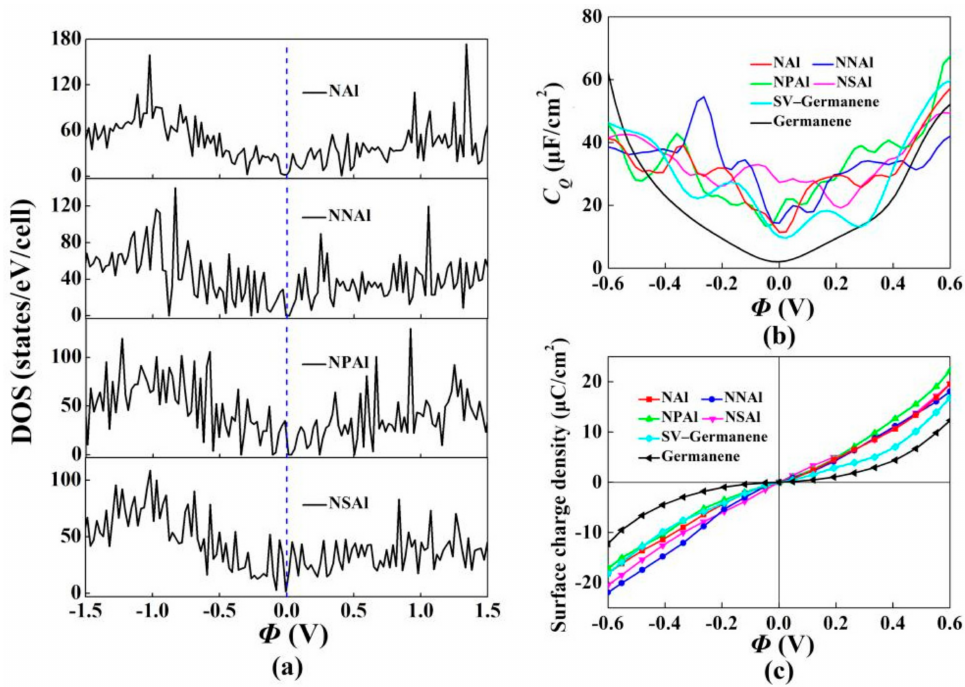
Figure 11. ( a ) Density of states (DOS) of multilayered structures of single-vacancy germanene co-doped with N/P/S/Al; ( b ) Calculated quantum capacitance of multilayered structures of the N/P/S/Al co-doped with single-vacancy germanene; ( c ) Surface charge density with Φ between − 0.6 V and 0.6